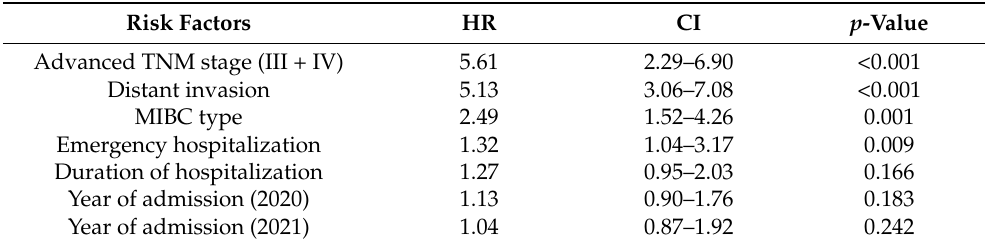
Table 4. Risk factors for urothelial cancer progression after the initial hospital